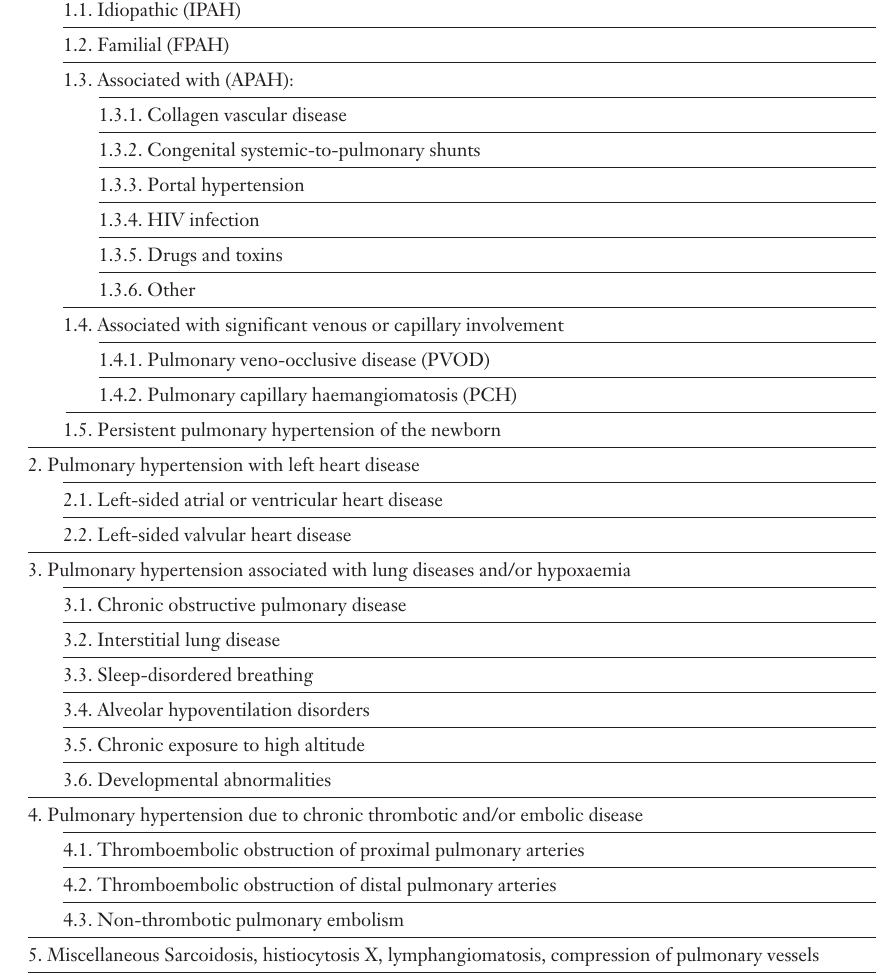
Clinical Classification of Pulmonary Hyper- tension (Venice 2003), see reference [1].